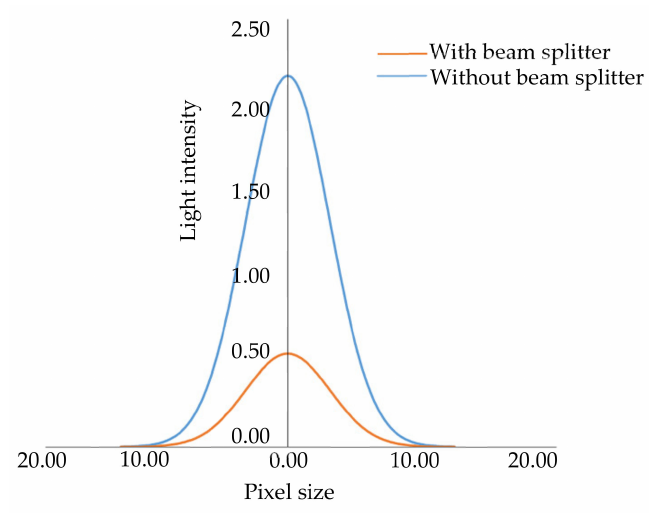
Figure 3. Effect of beam splitter on reflected light intensity.